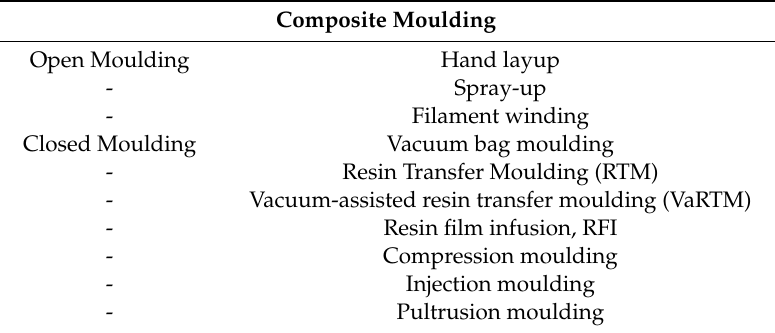
Table 3. Various types of open and closed moulding techniques [42].